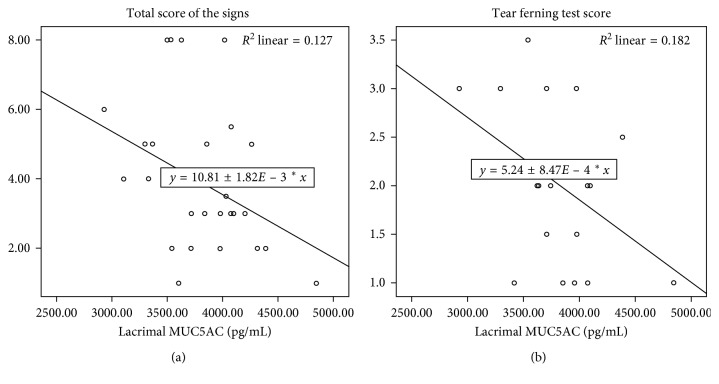
Lacrimal MUC5AC levels correlates inversely with TSS (total score of the signs) (p=0.042, R = −0.356) (a) and with TFT (tear ferning test) score (p=0.047, R = −0.427) (b) of VKC (vernal keratoconjunctivitis) patients for less severe VKC and better quality of the tear mucous component.